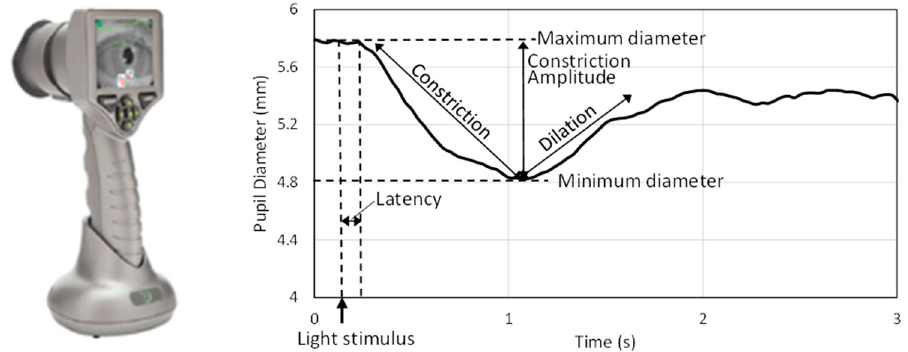
Figure 1. Handheld PLR-3000 device ( left ) and a typical pupil diameter time history and pupillary response parameters ( right ).